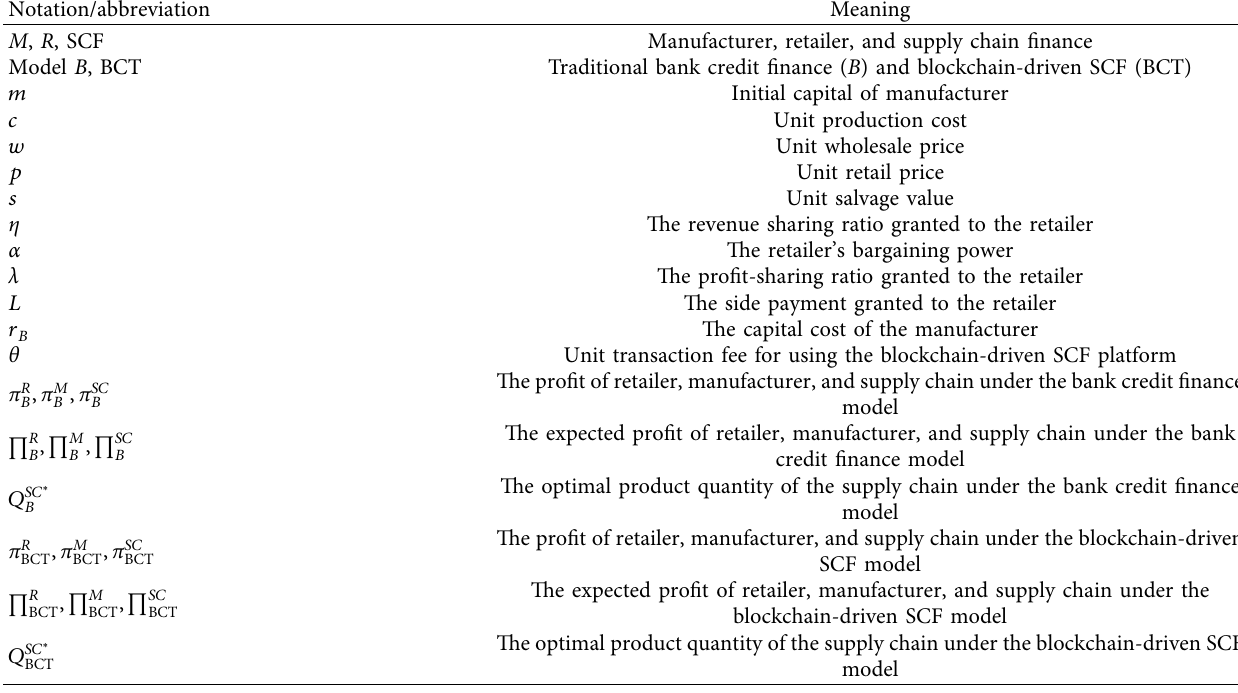
Table 2: Notation/abbreviation and the respective